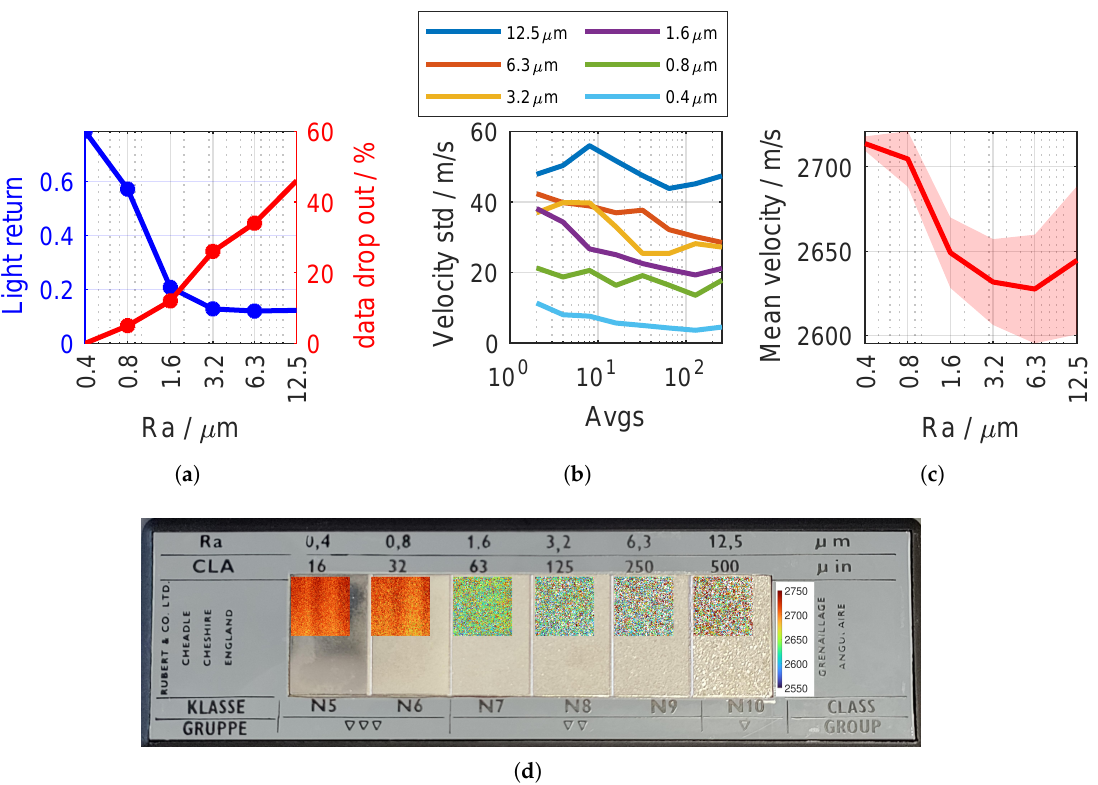
Figure 4. Results from grit blast comparator demonstrating the key features of laser ultrasound measurements on rough surfaces. ( a ) The light returned to the detector (blue) and percentage of positions on the sample where no measurement could be made (red). ( b ) Velocity standard deviation with averaging. ( c ) Mean velocity (bold) with increasing roughness, where the filled region represents velocity standard deviation. ( d ) SRAS velocity maps overlaid onto the grit blast comparator from which they were